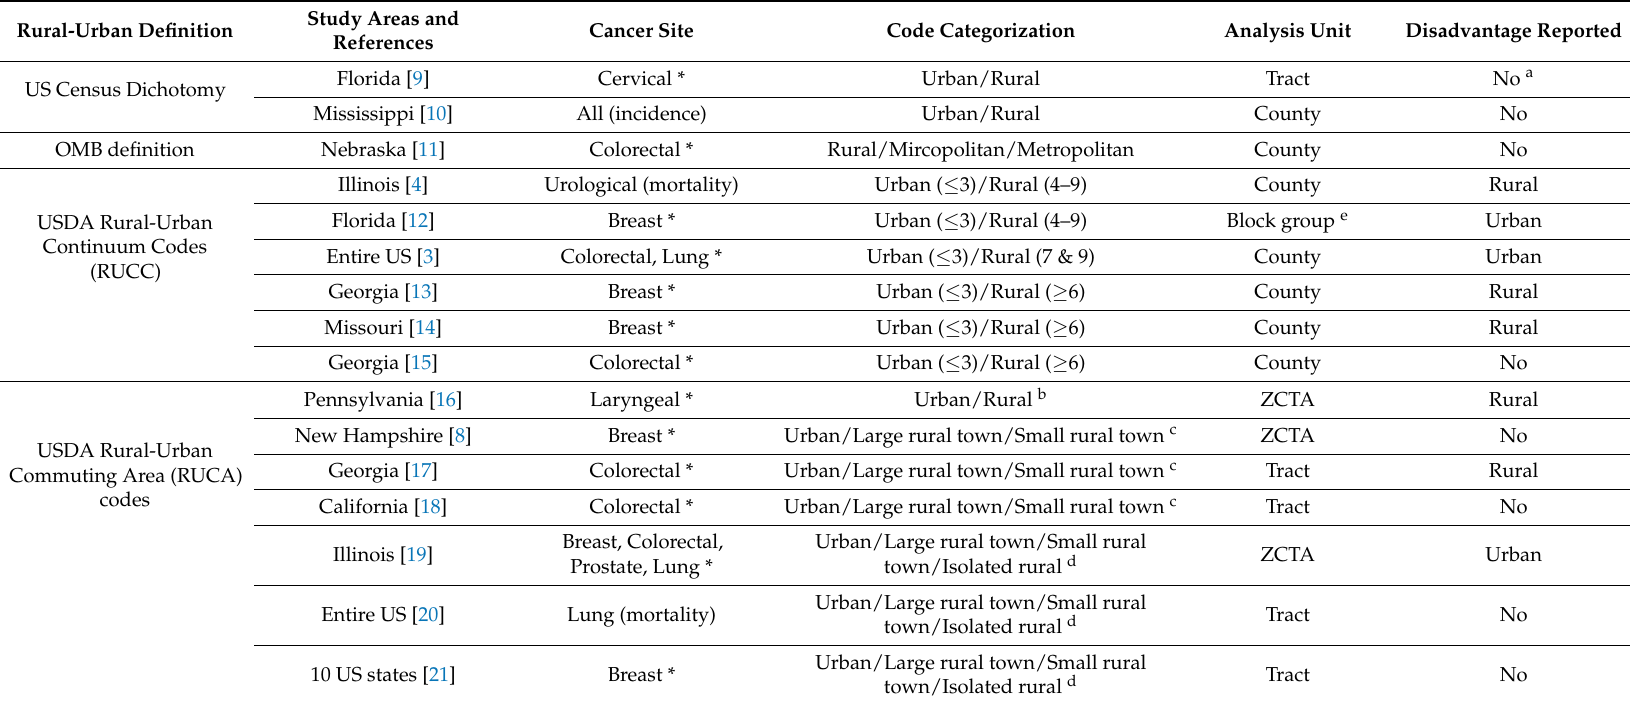
Table 1. Cancer studies in the US with different rural-urban definitions and